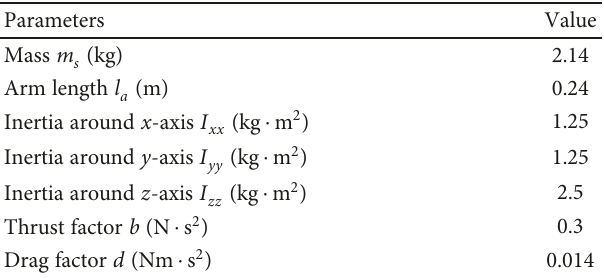
Figure 10: Initial formation of fi ve quadrotors. Table 1: Quadrotor dynamic parameters.